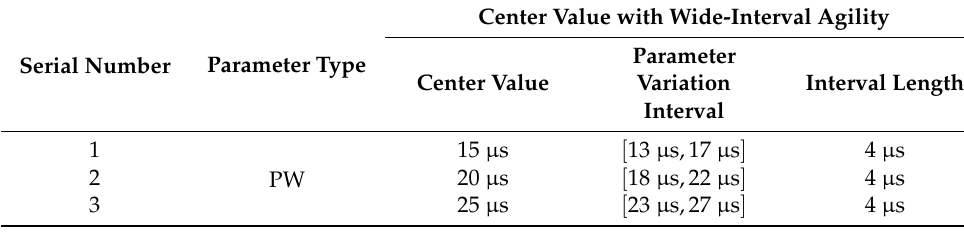
Table 2. The simulation parameters settings of anti-sorting signal designed in the